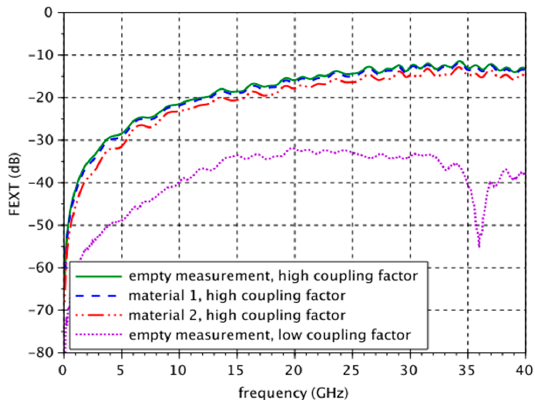
Figure 18. FEXT of coupled microstrip lines without and with two different ACP specimens in comparison to weakly coupled lines without an ACP specimen.